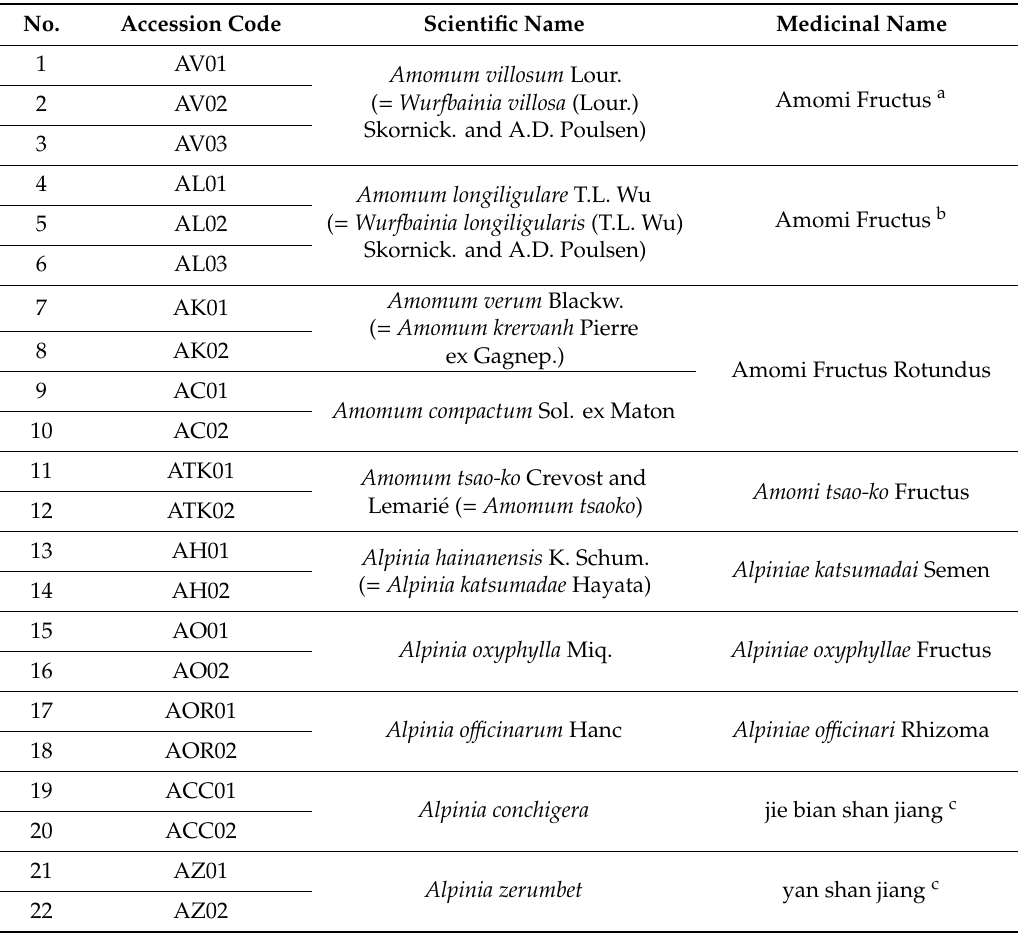
Table 2. List of reference samples compared with Amomi Fructus and its adulterants.